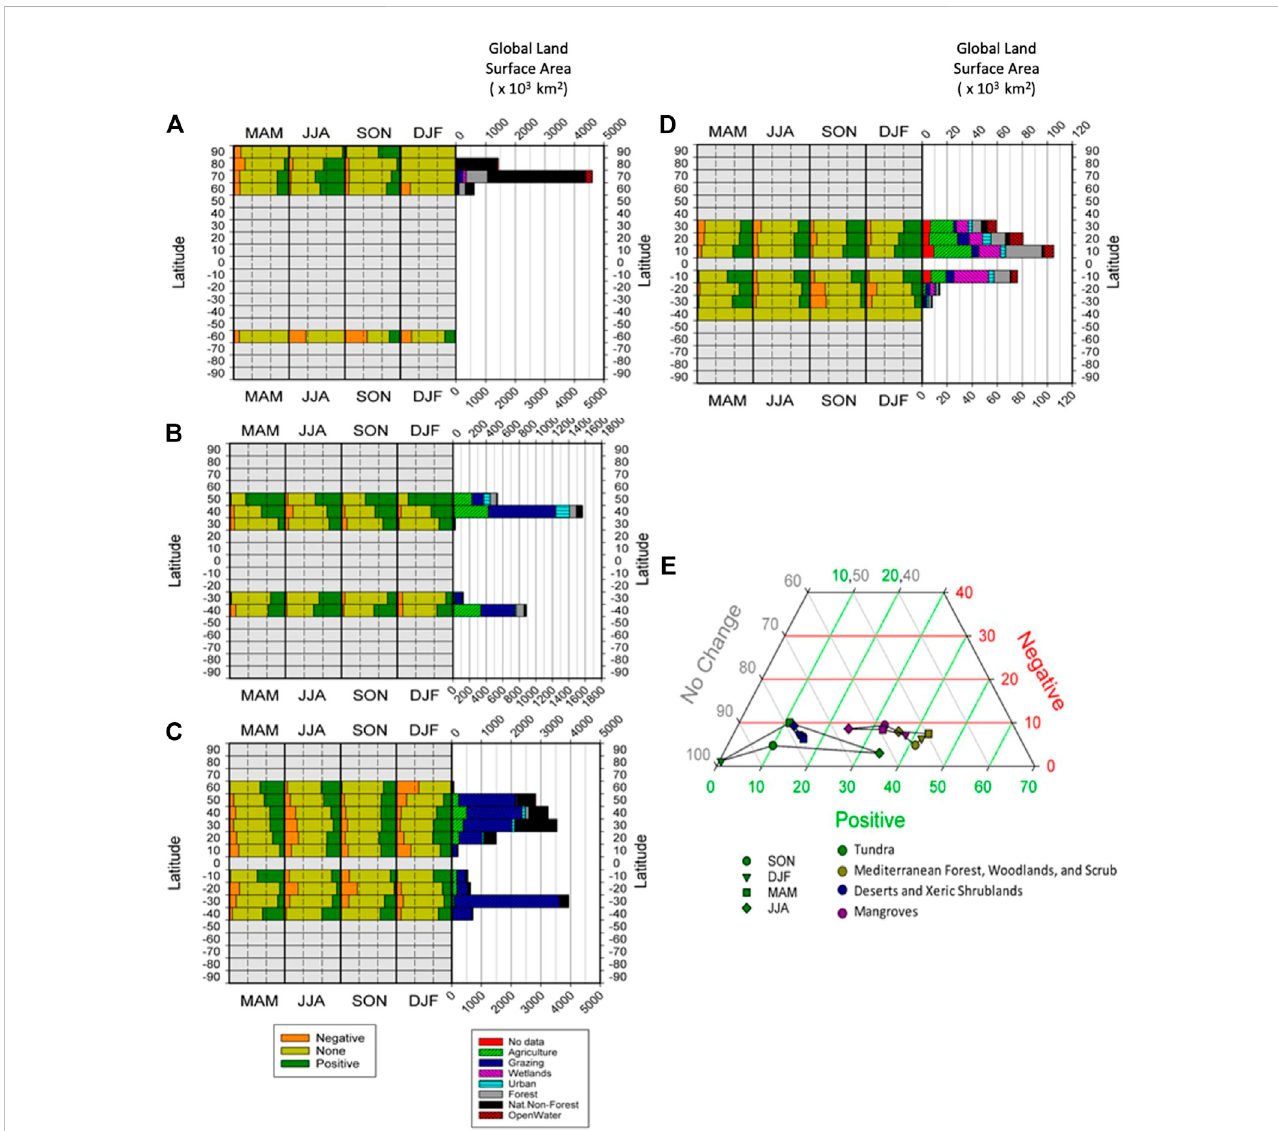
FIGURE 7 Composition of signi fi cant persistence values (Negative, None, Positive) in each biome, broken down by latitudinal band, with land use diversity of each bank also shown, for (A) Tundra, (B) Mediterranean Forest, Woodlands and Scrub, (C) Deserts and Xeric Shrublands, (D) Mangroves and (E) Ternary plot of the seasonal changes in percentages of global areas returning signi fi cant percentages of positive and negative persistence, and those reporting to signi fi cant persistence, for four other